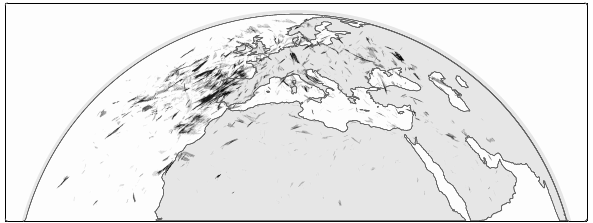
Figure 4. overage of the 2375 tracked contrails. The darker shades of blue indicate a larger number of